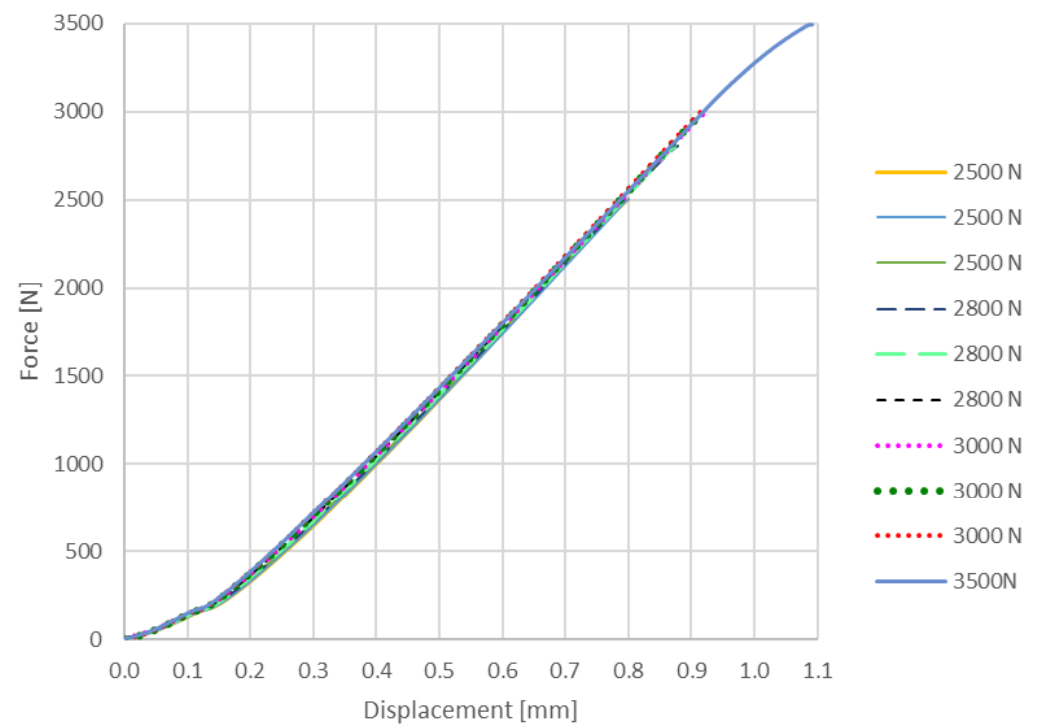
Figure 10. Proof of compression elastic range up to 3000 N for vertically layered samples.